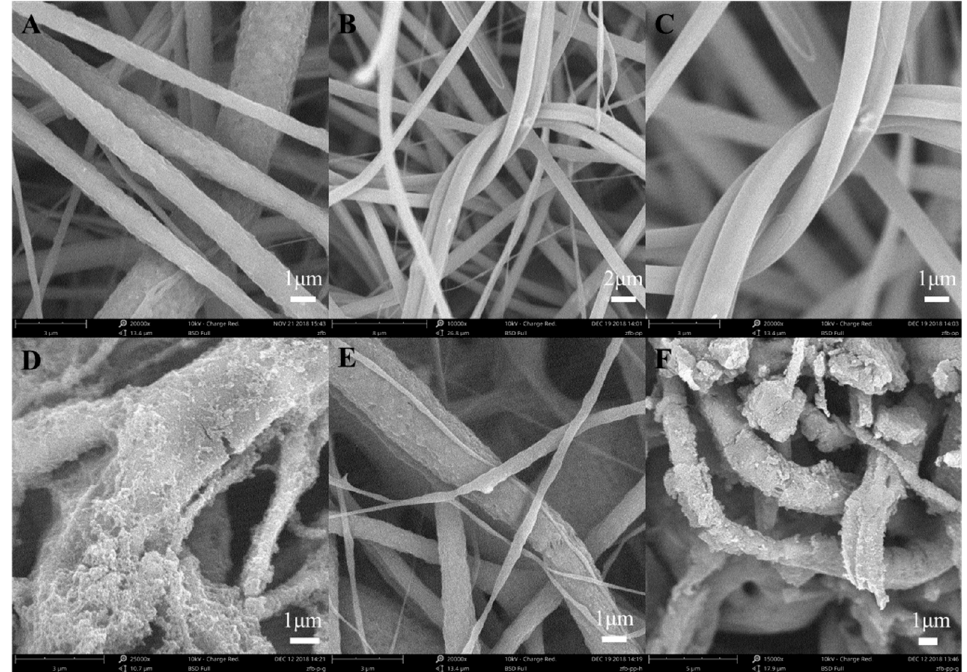
Figure 3. SEM images of ( A ) single electrospinning PVDF(TBT) nanofiber; ( B ) PVDF(TBT)/PVP(TBT) nanofiber; ( C ) PVDF(TBT)/PVP(TBT) nanofiber; ( D ) PVDF (TBT)-GQDs nanofiber; ( E )